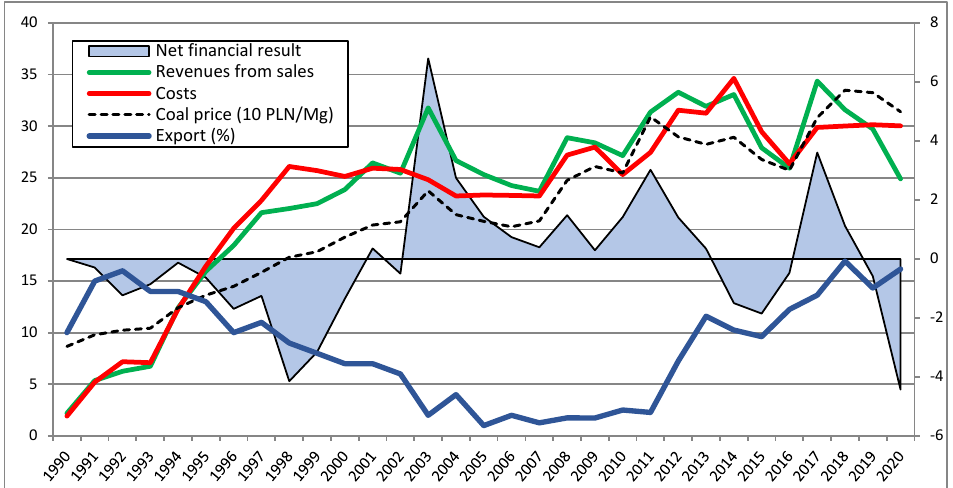
Figure 1. Financial results of coal mining enterprises in 1990–2020 (bn PLN). Note: net financial result and export—right axis. Source: authors’ research based on GUS in Warsaw (Statistical Head Office in Warsaw, Poland) — databases of limited access. Available online: https://stat.gov.pl/en/da- tabases/ (accessed on 4 February 2022); Pont Info Warsaw —Gospodarka SŚDP— commercial data- bases. Available online: http://baza.pontinfo.com.pl/index.php (accessed on 2 February 2022).